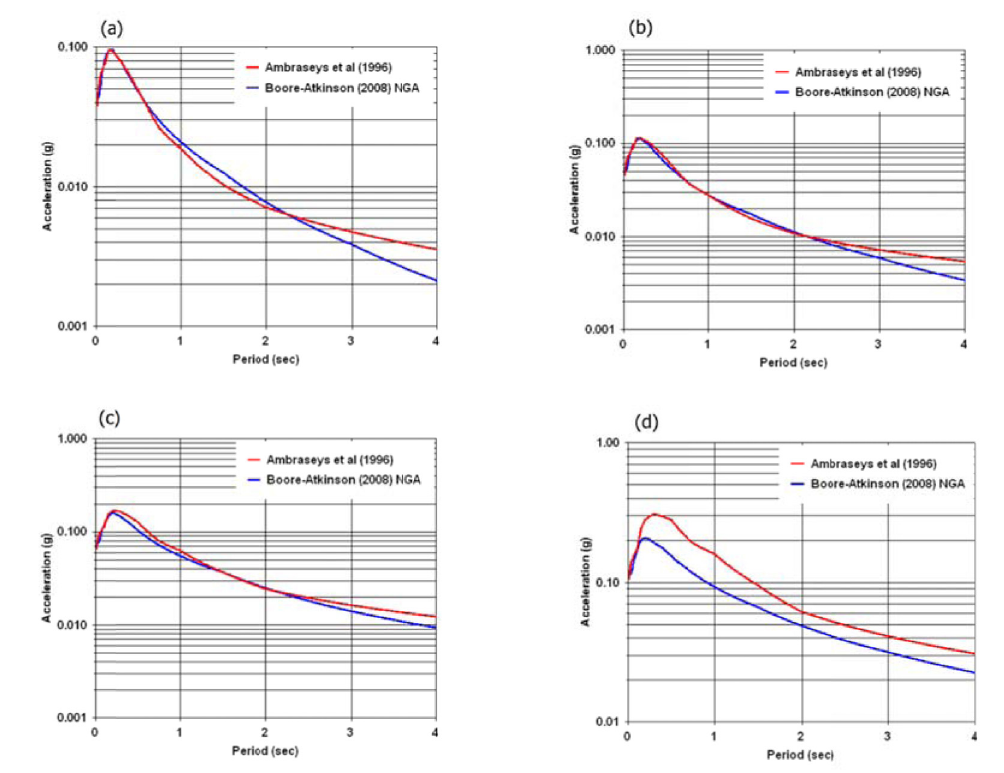
(0.01 s) and MRP of 50-year, (b) =6.3 a a